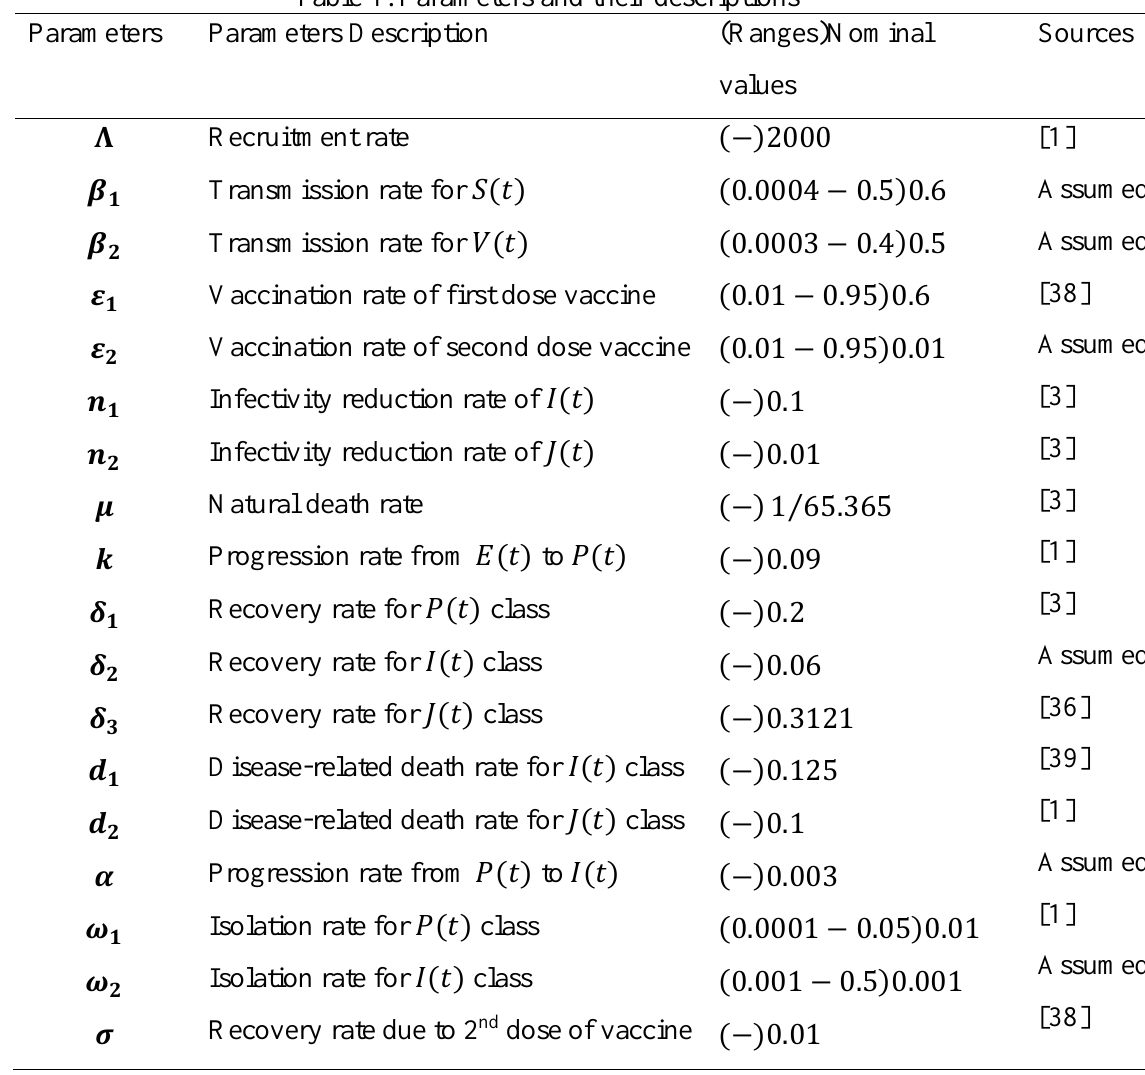
Table 1. Parameters and their